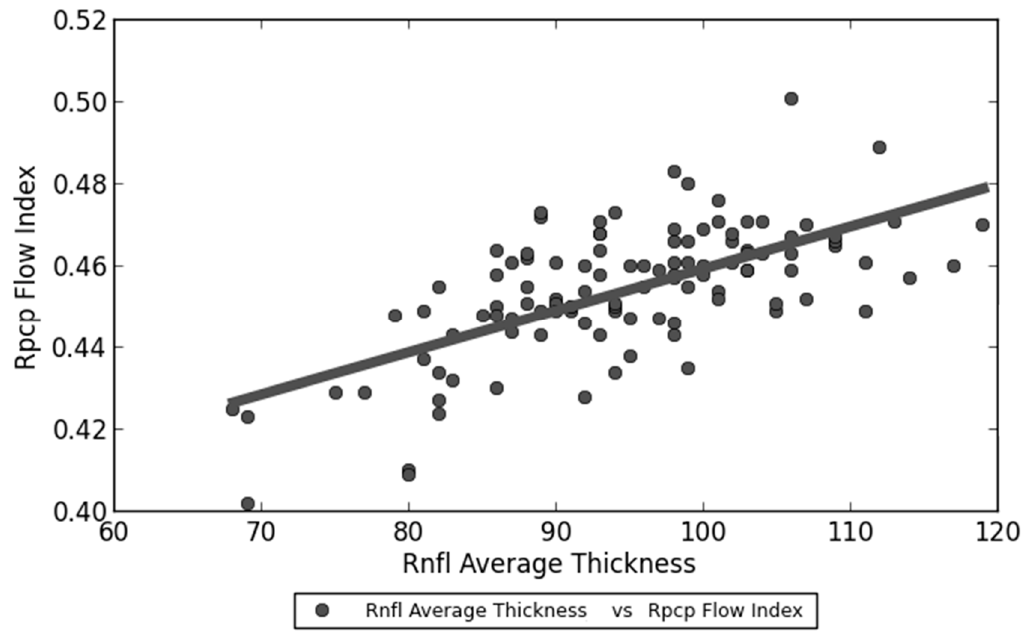
Figure 4. Linear correlation between RNFL (Retinal nerve fiber layer) average thickness and RPCP (Radial peripapillary capillary plexus) flow index within post-COVID-19 group patients.